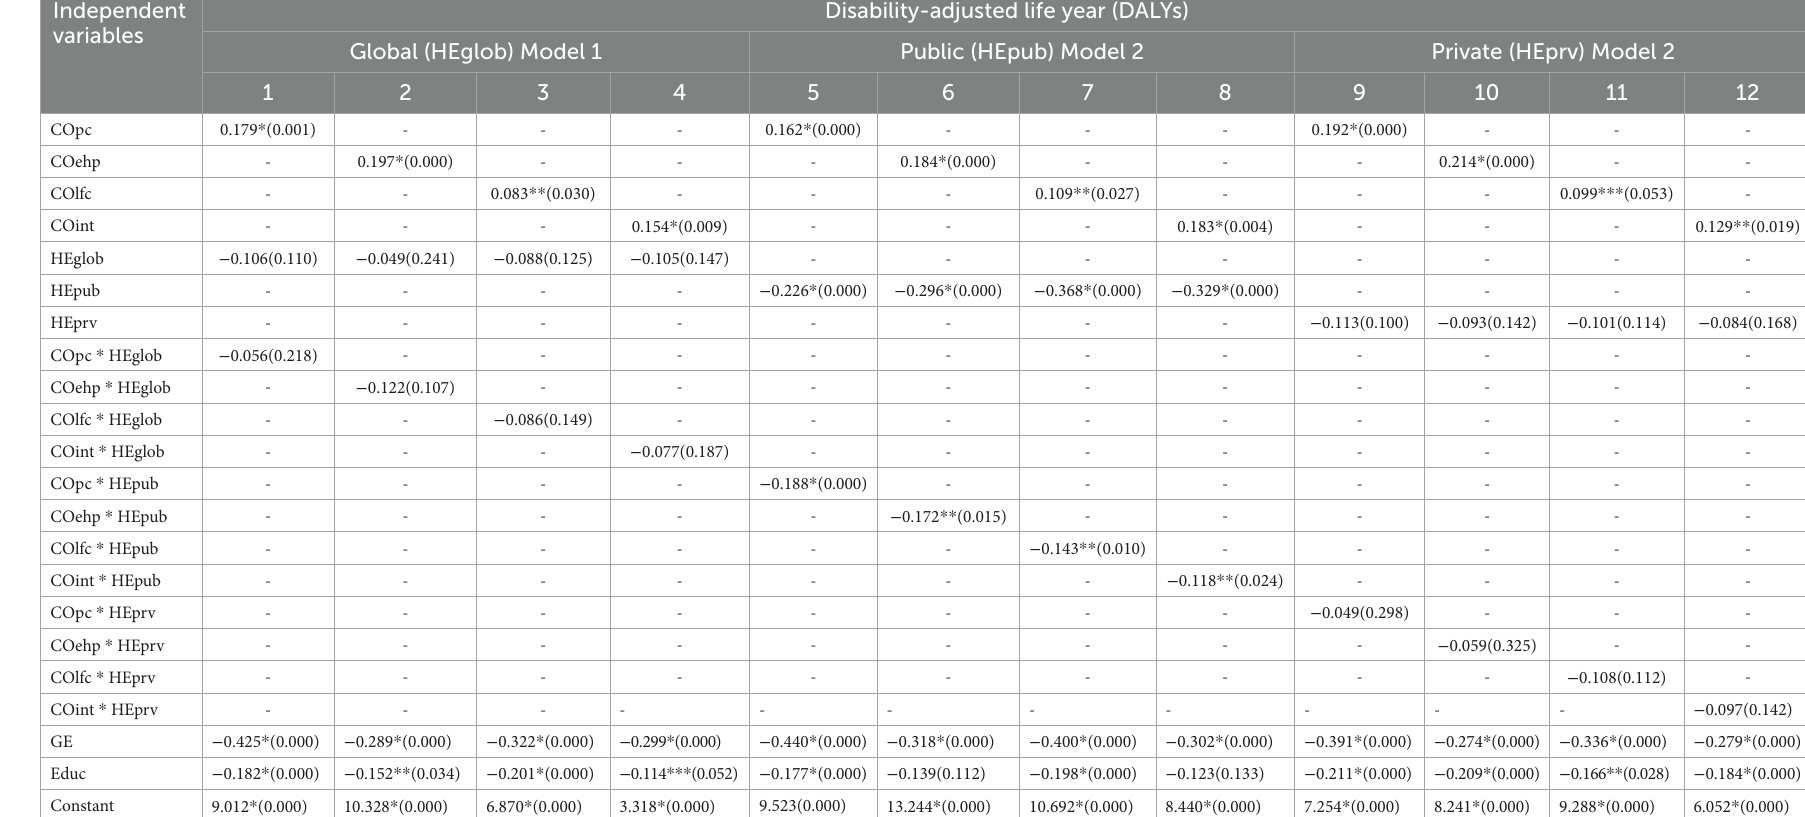
TABLE 5 Results of the impacts of health expenditure and environmental degradation on disability. Independent